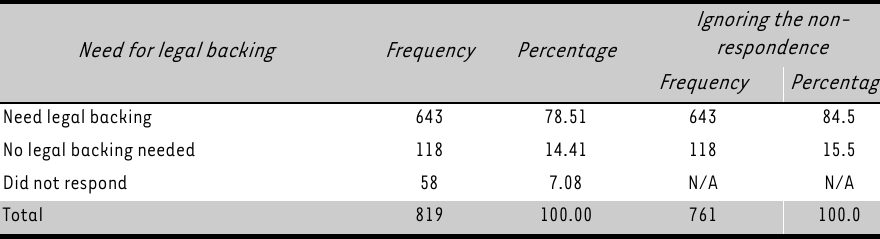
Ignoring the non-